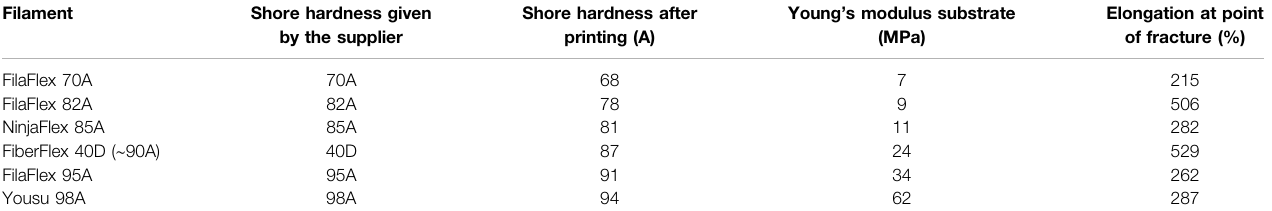
TABLE 1 | Mechanical properties of the printed TPU fi lament without integrated in situ sensing elements. The Young ’ s modulus and elongation at the point of fracture are derived from Figure 2 . Filament Shore hardness given Shore hardness after Young ’ s modulus substrate Elongation at point by the supplier printing (A) (MPa) of fracture (%)